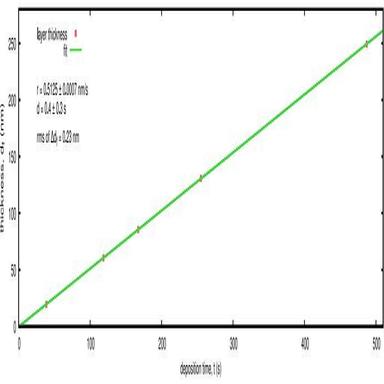
Thickness of Nb2O5 layers versus deposition time. The line corresponds to fit based on linear formula (.